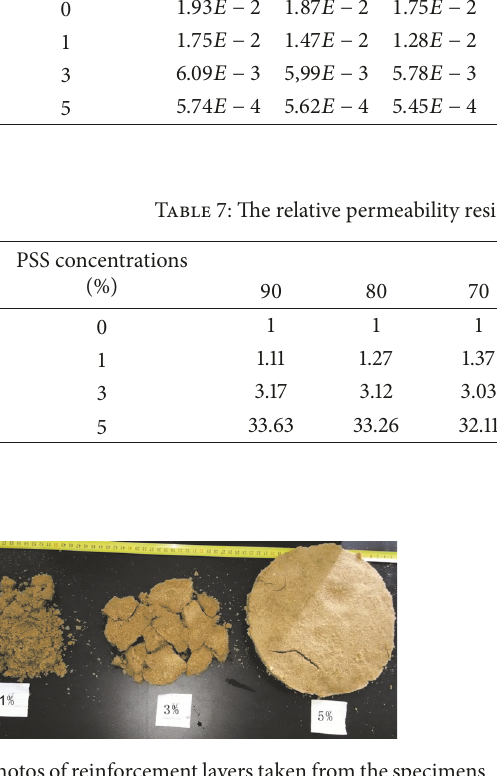
Figure 15: Photos of reinforcement layers taken from the specimens with curing time of 24 h after the porous permeability